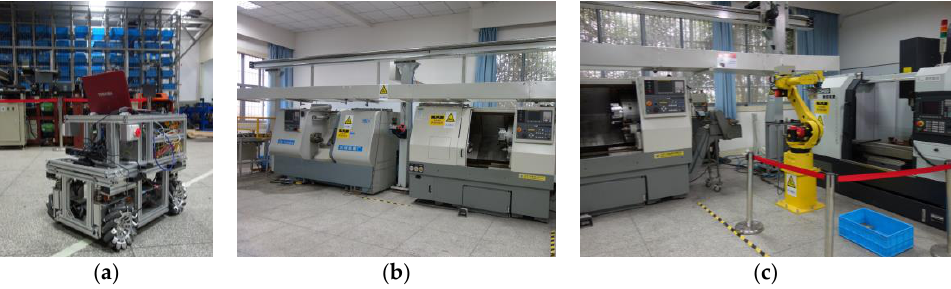
Figure 8. The main equipment of the intelligent manufacturing system. ( a ) Stero warehouse; ( b ) CNC lathes and gantry manipulator; ( c ) industrial robot and milling machine.